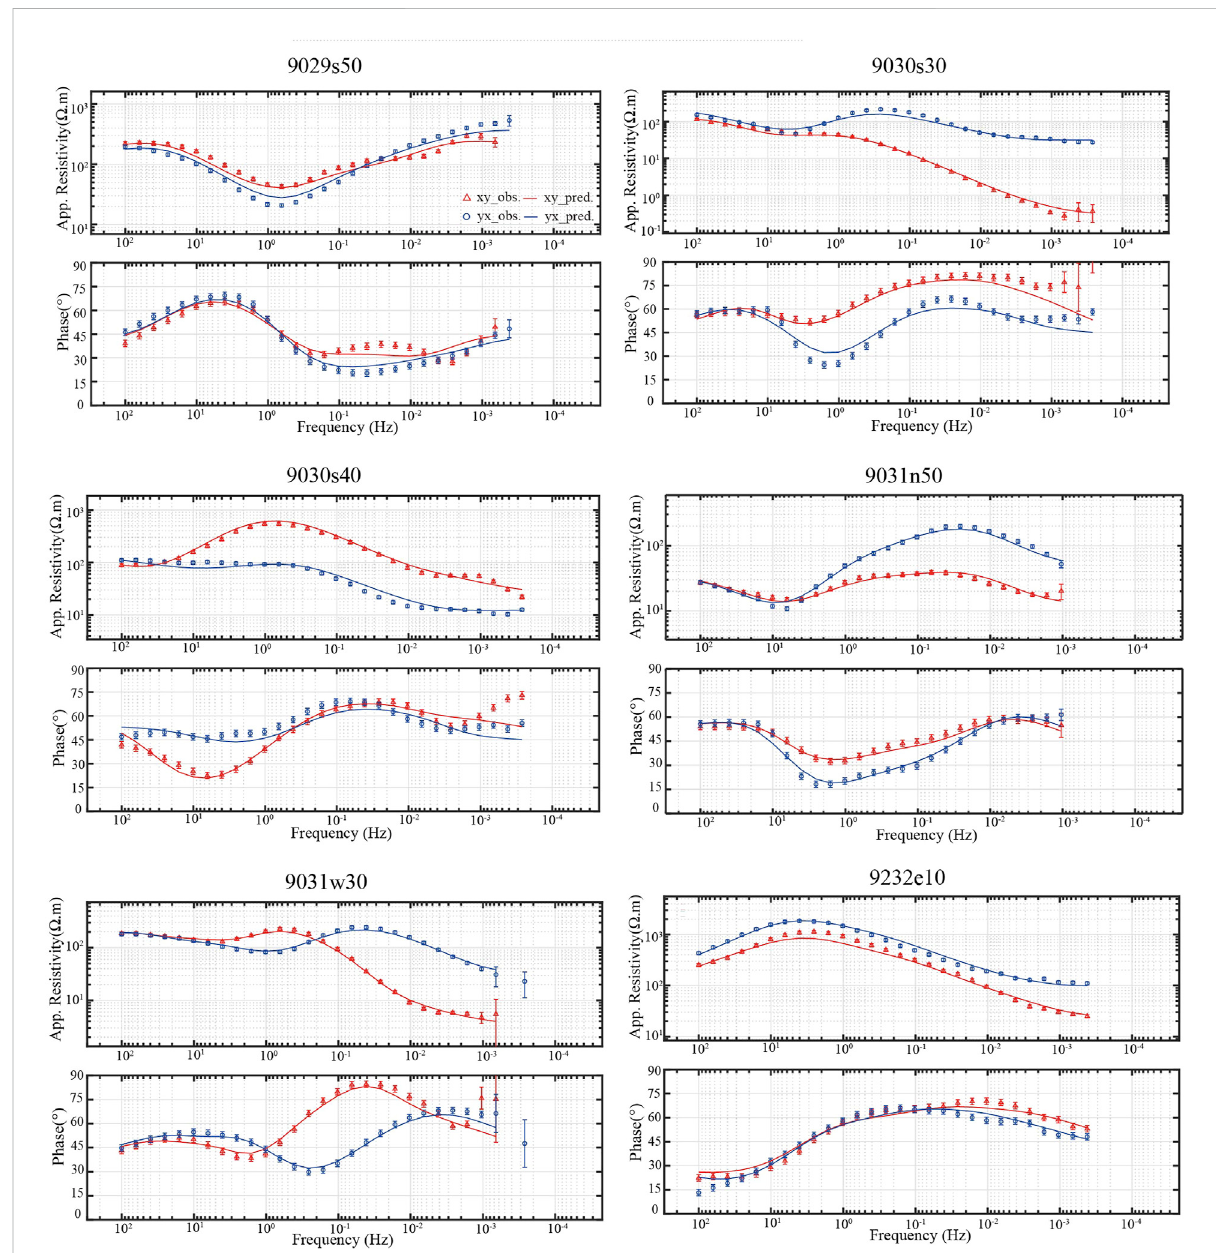
FIGURE 2 Examplesofapparentresistivity andphasecurvesforthesites9029s50,9030s30,9030s40,9031n50,9031w30,9232e10 (markedbythewhite circles in Figure 1A). The red triangles and blue circles represent the off-diagonal elements of the impedances. The solid lines (red, blue) show the predicted responses for the preferred model. The error bars are corresponding to the measurement errors of the observed